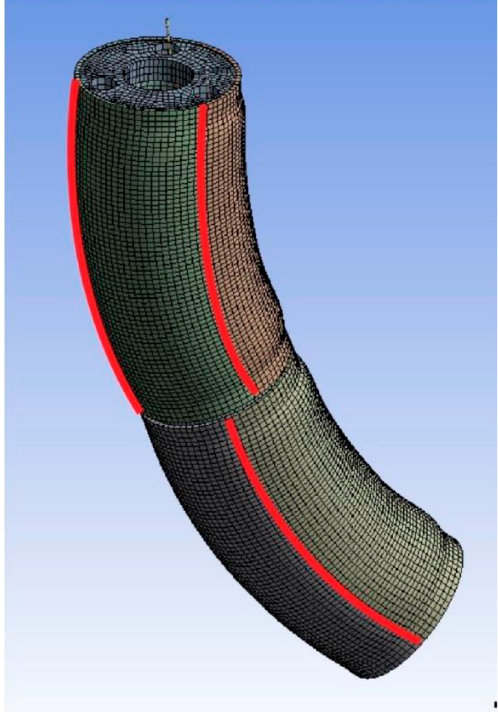
Figure 18. Deformed node paths. Source: authors.